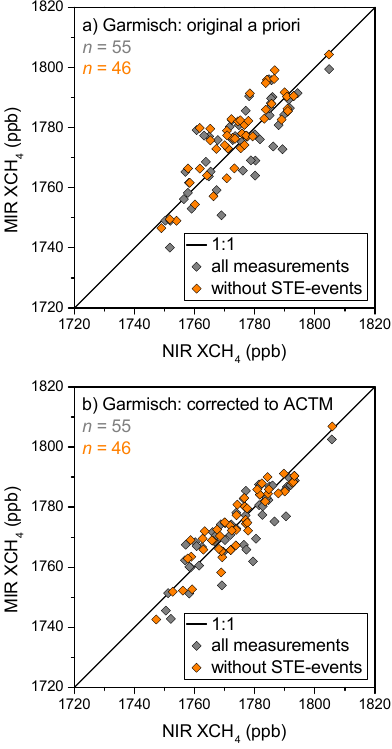
Figure 9. Scatter plot of MIR and NIR monthly means for Garmisch XCH 4 obtained from all FTIR measurements (black diamonds) and FTIR measurements which are not affected by STE events (red di- amonds), respectively. (a) MIR and NIR XCH 4 retrieved with their original retrieval a priori profiles and (b) a posteriori corrected to common ACTM profiles. Note: the data set is not identical to that in Sect. 3 because STE trajectories are not available for the com- plete time